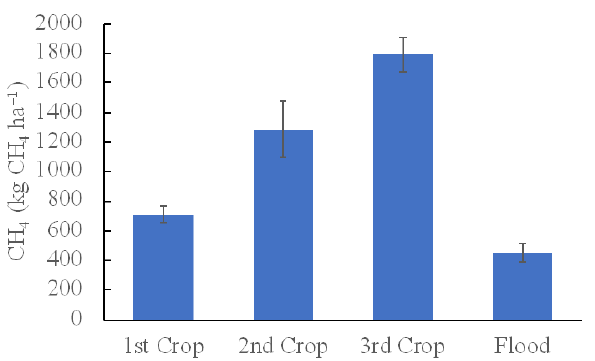
Figure 1. Total CH emissions. Five-year average of CH 4 represent 95% CI (n =